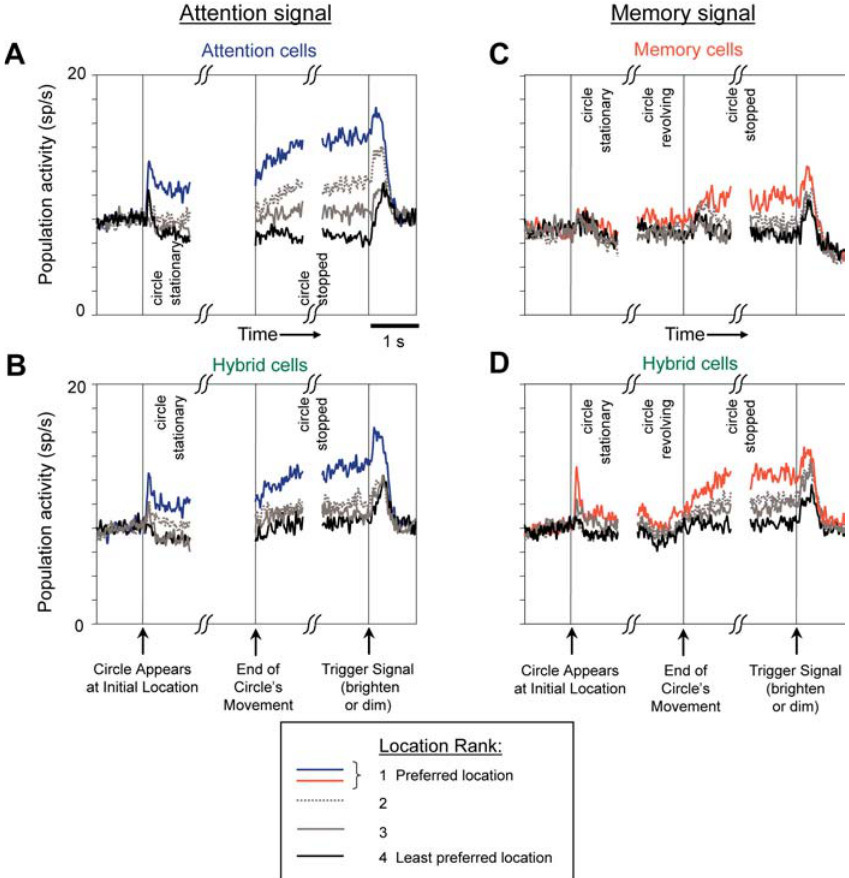
On Rem-trials (dashed curves in Figures 7F, 8A–8C, and 8E), the circle’s brightening instructed a saccade to the remembered location (marked by the red ‘‘ R ’’ in Figure 8E).